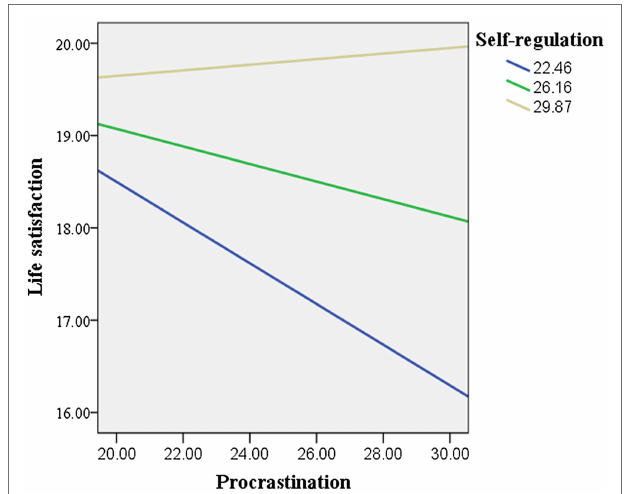
FIGURE 2 | Moderation effect of self-regulation in